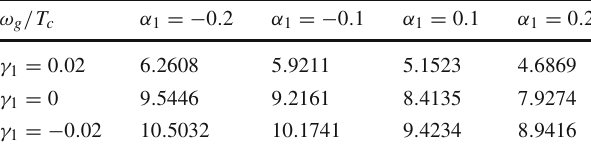
Table 4 The superconducting energy gap ω g / T c with different α 1 and